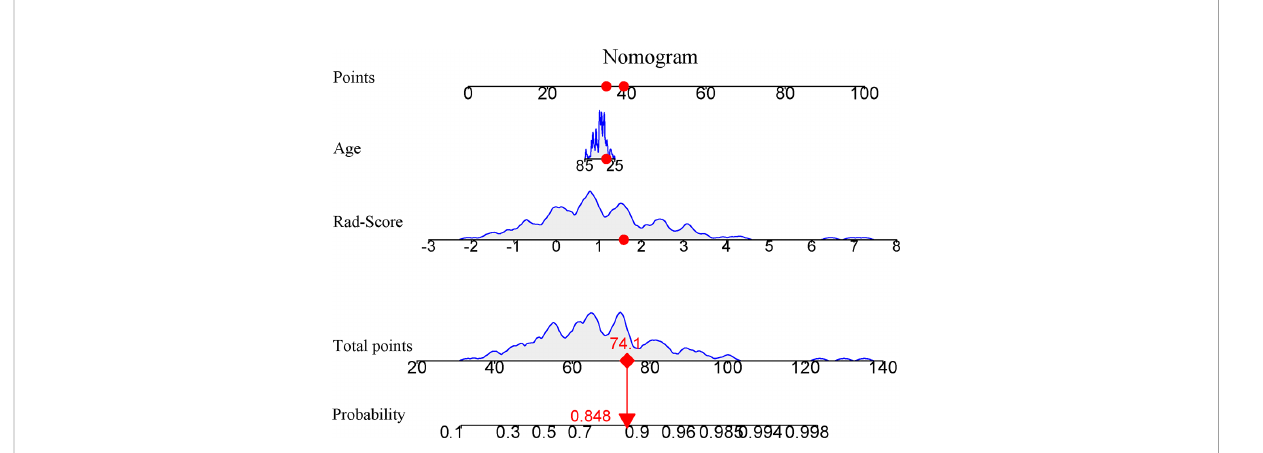
FIGURE 9 Nomogram based on the combination of the clinical risk factors and Rad-Score was developed using logistic regression analysis. If a patient with the radiomics score of 1.637 and age of 56, and then the probability of the high Ki-67 expression of breast carcinoma is 0.848 (red